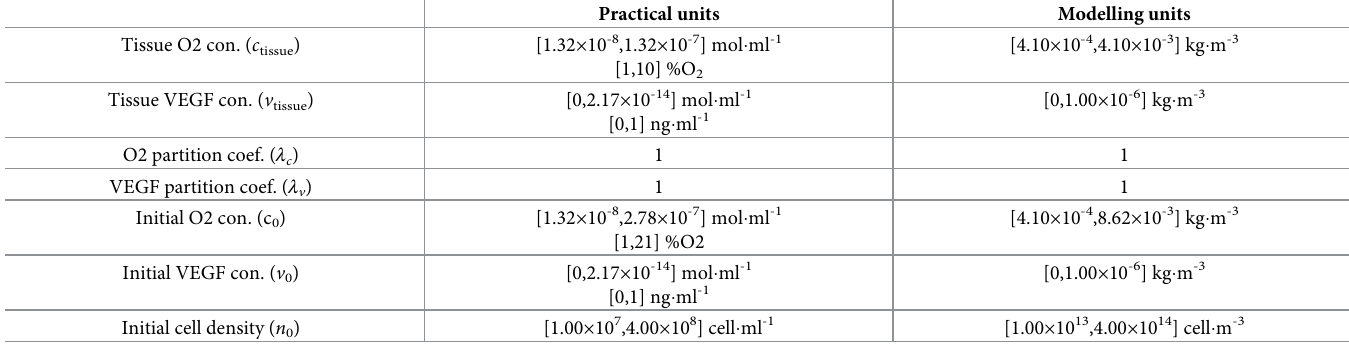
Table 6. Initial and boundary conditions